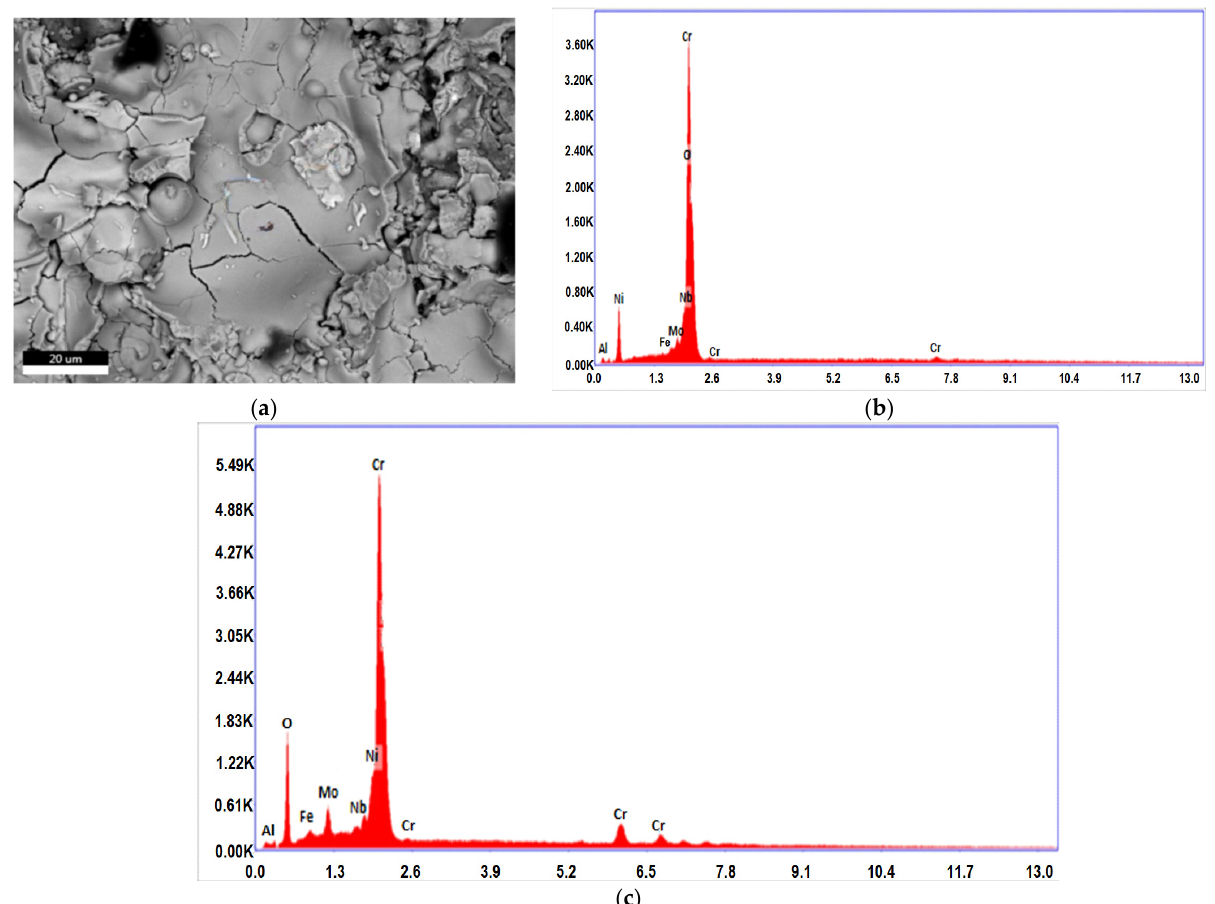
Figure 5. Coated EN8 ( a ) SEM morphology ( b ) EDS spectrum for isothermal oxidation after 48 h at 1050 °C and ( c ) EDS spectrum at 900 °C.